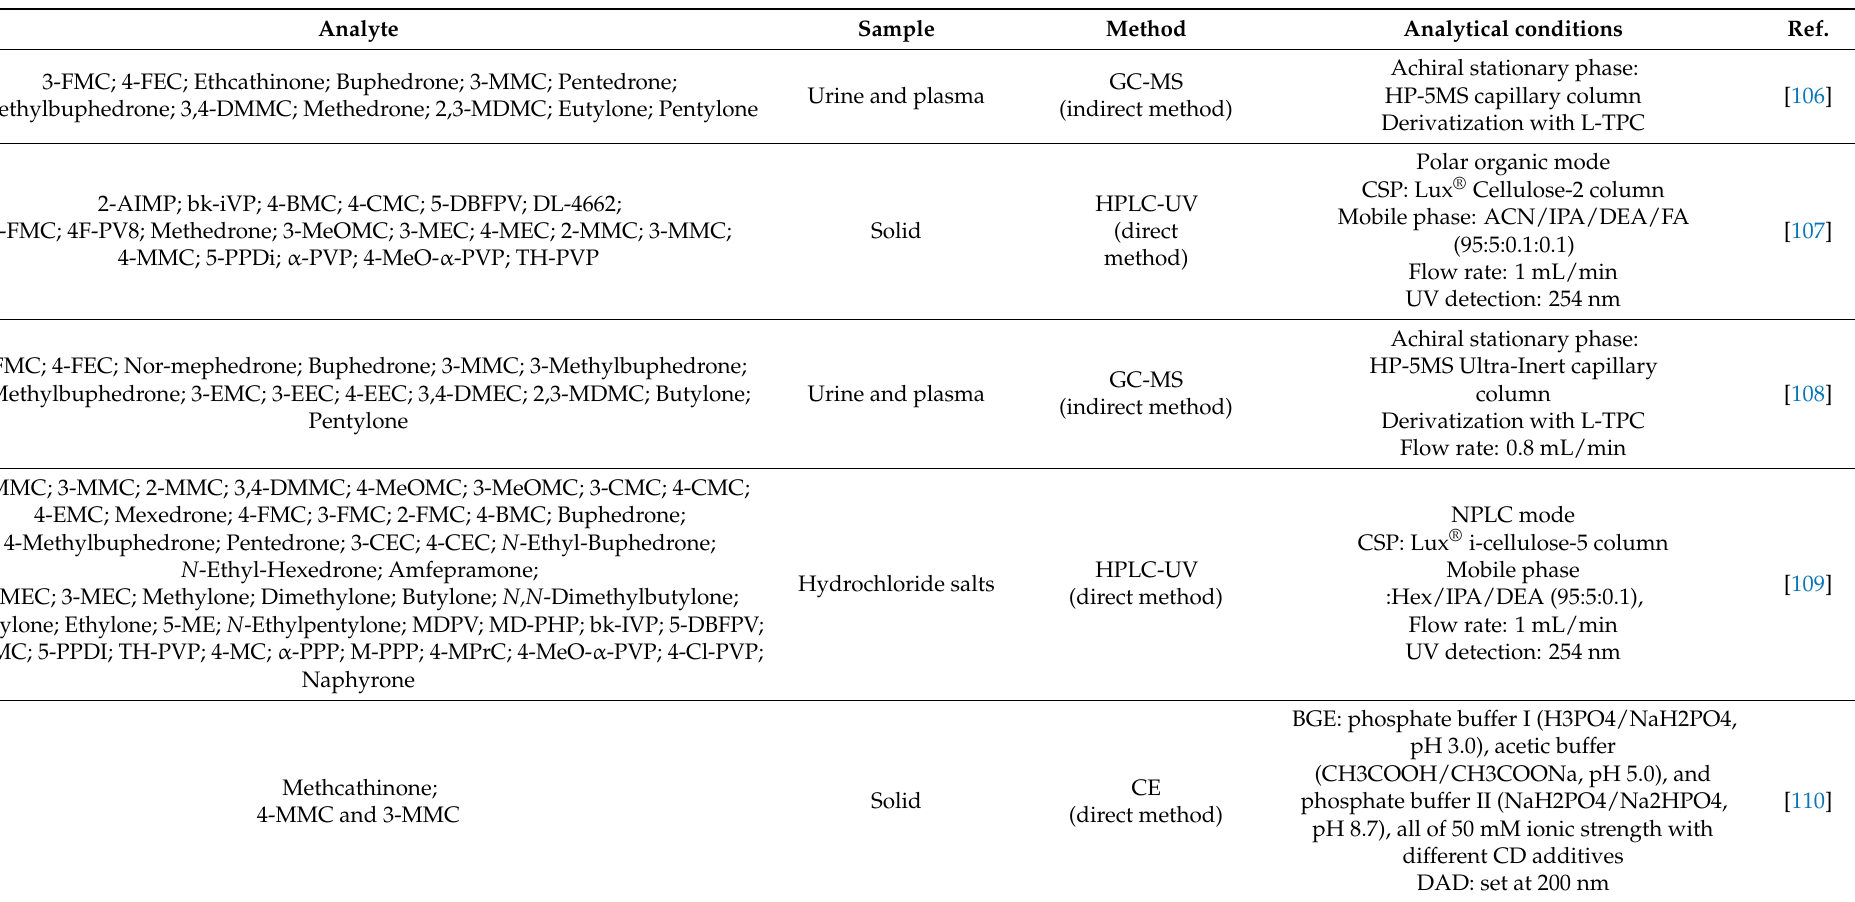
Table 1. Development of analytical methods for enantioresolution of synthetic cathinones from 2018 to